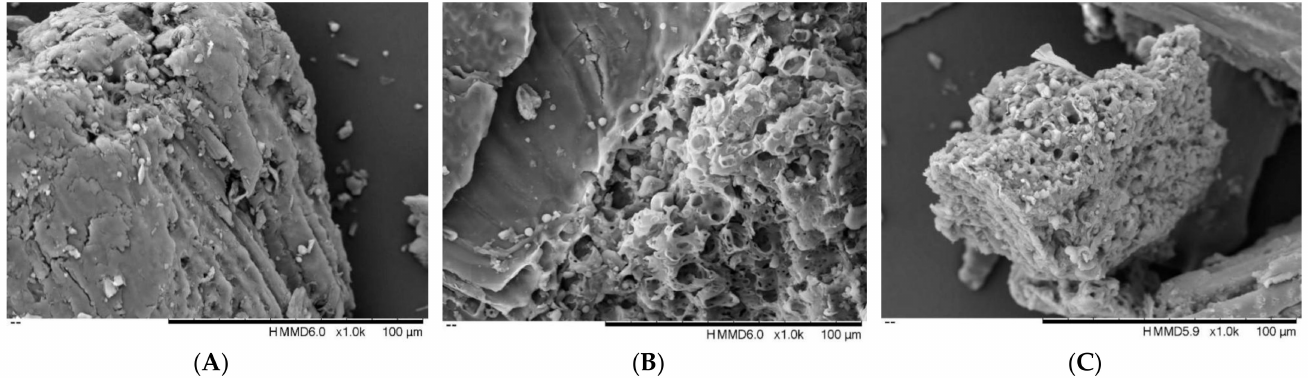
Figure 5. Scanning electron micrographs of foxtail millet husk before ( A ) and after extraction with UAE-DES ( B ) and UAE ( C